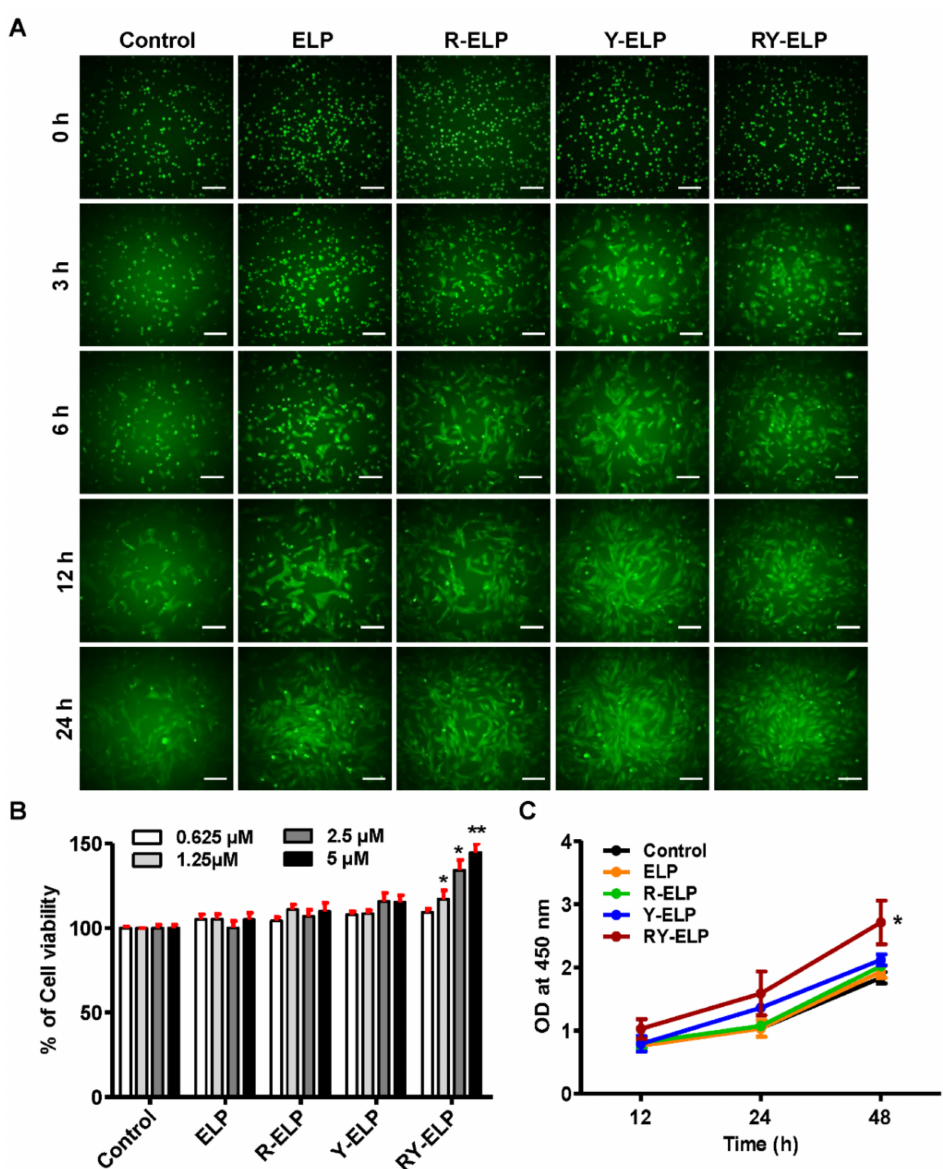
Figure 2. Cell adhesion, viability, and proliferation assay of IHF cells. ( A ) Live imaging of IHF cell attachment on fusion ELP (ELP, R-ELP, Y-ELP, and RY-ELP) modified surface at different time intervals ( n = 3), Scale bars: 50 µ m. ( B ) Cell viability of IHF cells was evaluated post 24 h cultured on a fusion-ELP-coated surface ( n = 3), ** p < 0.01 and * p < 0.05 significant difference of respective fusion ELPs compared with uncoated control. ( C ) The proliferation rate of IHF cells on fusion-ELP-modified surfaces was evaluated at different time intervals (12, 24, and 48 h) ( n = 3), * p < 0.05 significant difference for RY-ELP compared with uncoated surface